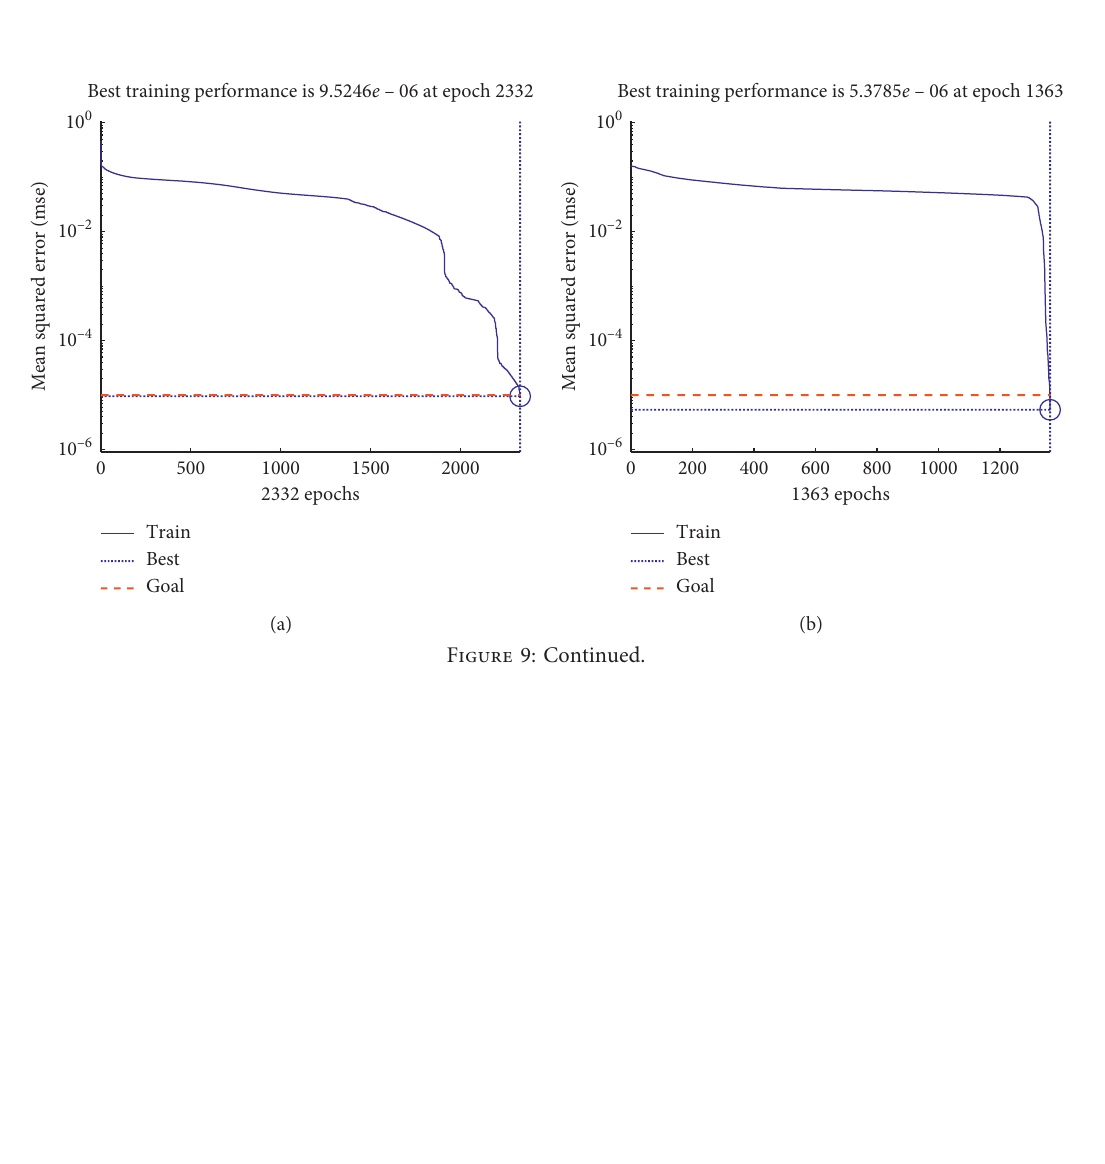
Figure 8: Comparison of adaptability changes of three different algorithm.